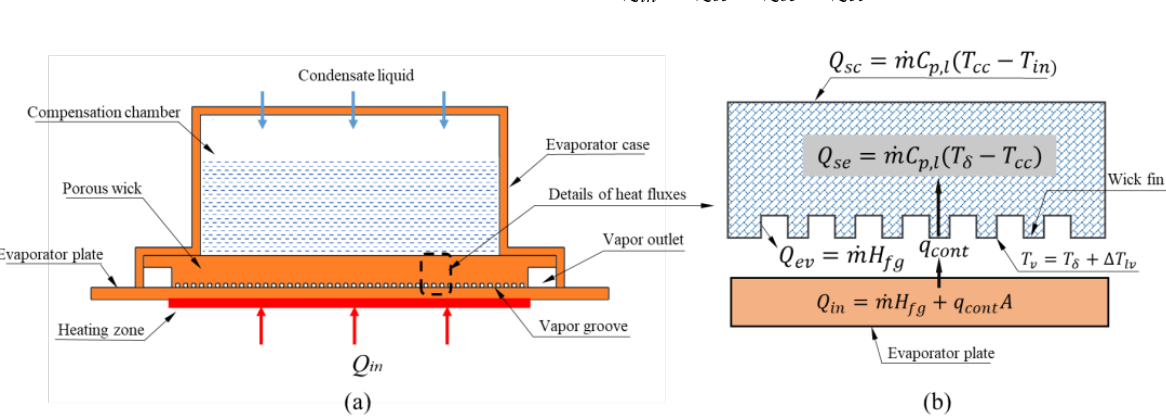
Figure 5. Schematic of ( a ) cross-sectional view of the evaporator-CC structure and ( b ) heat flux details in the wick.